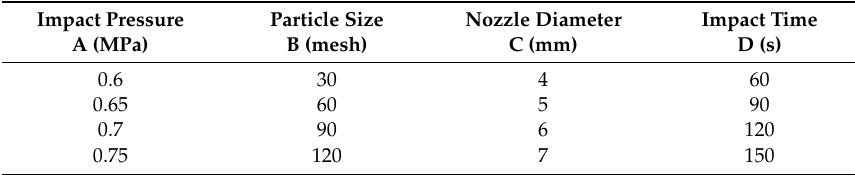
Table 1. Experimental conditions of shot